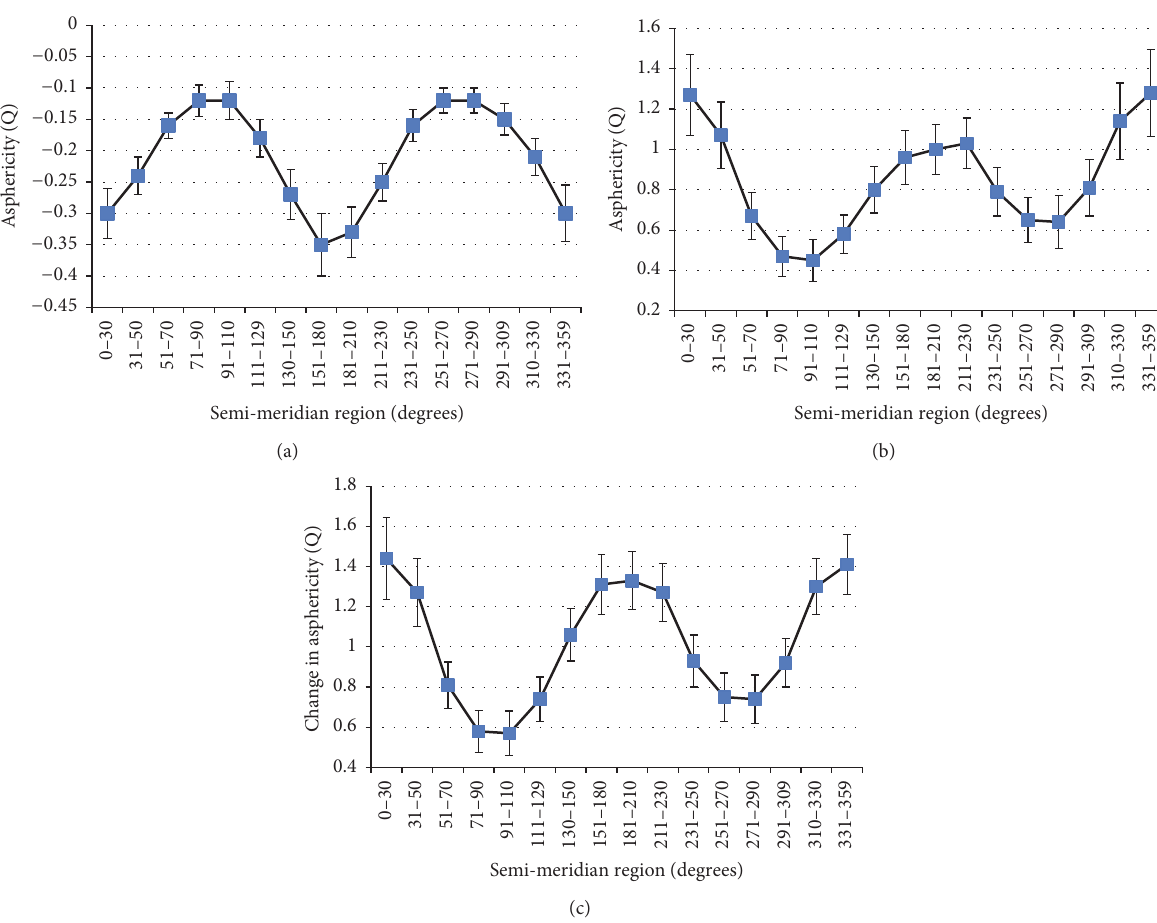
Figure 4: Variation in the asphericity ( 𝑄 ) as a function of the semimeridian region of the anterior corneal surface for all subjects. Bars denote the 95% confidence interval (CI). (a) Preoperation; (b) postoperation; (c) the pre- and postoperative change in 𝑄 ( Δ𝑄